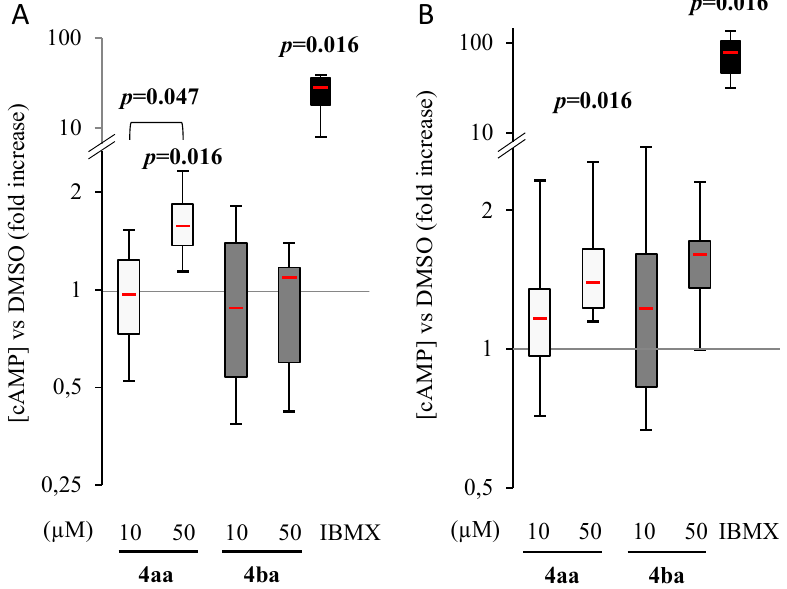
Figure 2. Pyridazinone scaffold-based molecule 4aa increases intracellular cAMP. Intracellular cAMP versus DMSO on human osteosarcoma cell lines Saos-2 ( A ) and MNNG/HOS ( B ) after 2 h of treatment with compounds 4aa , 4ba or IBMX. n = 7. p -values are given relative to DMSO on box-plots; the brackets indicate the conditions compared.